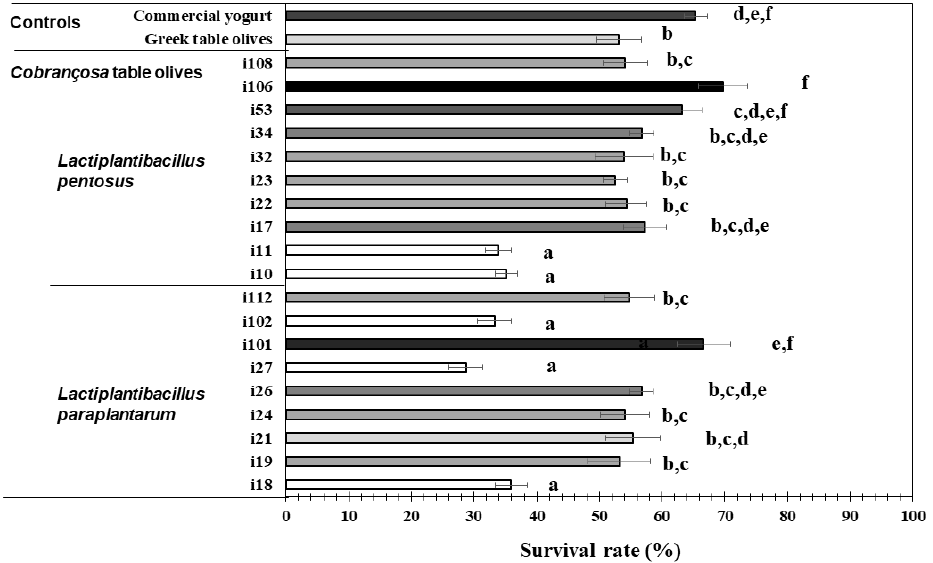
Figure 2. Gastrointestinal performance of native strains isolated from Cobrançosa table olives. Notes: Different letters represent significant differences ( p < 0.05) between strains. Lacticaseibacillus casei strains were isolated from probiotic commercial yogurt. Lactiplantibacillus pentosus B281 strain was isolated from Greek probiotic table olives [15] .